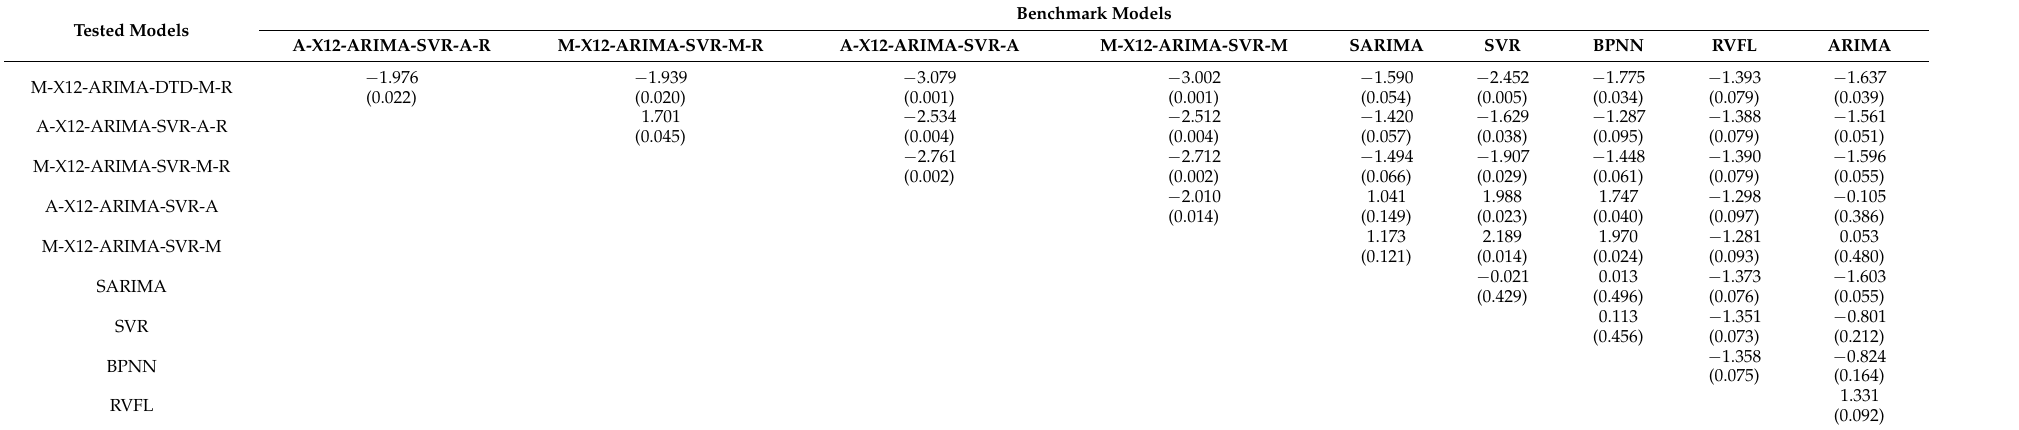
Table 18. DM test results across different models for gasoline consumption data in